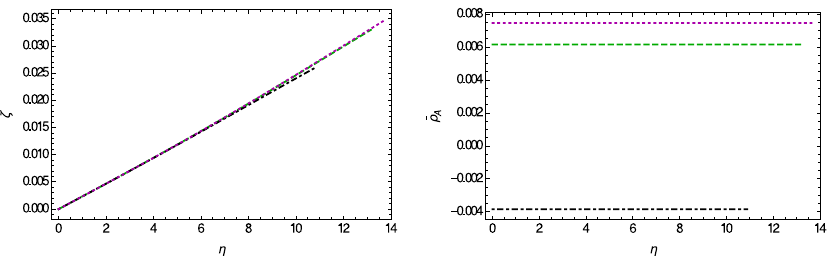
Fig. 23 Variation of ¯ ξ (left panel) and ¯ ρ A (right panel) as a function of distance from the center of the star η for the three-form field Bose–Einstein condensate stars, for three different values of the constant field potential ¯ λ : ¯ λ = 0 (dashed curve), ¯ λ = 0 . 0013 (dotted curve), and ¯ λ = − 0 . 01 (dot-dashed curve)